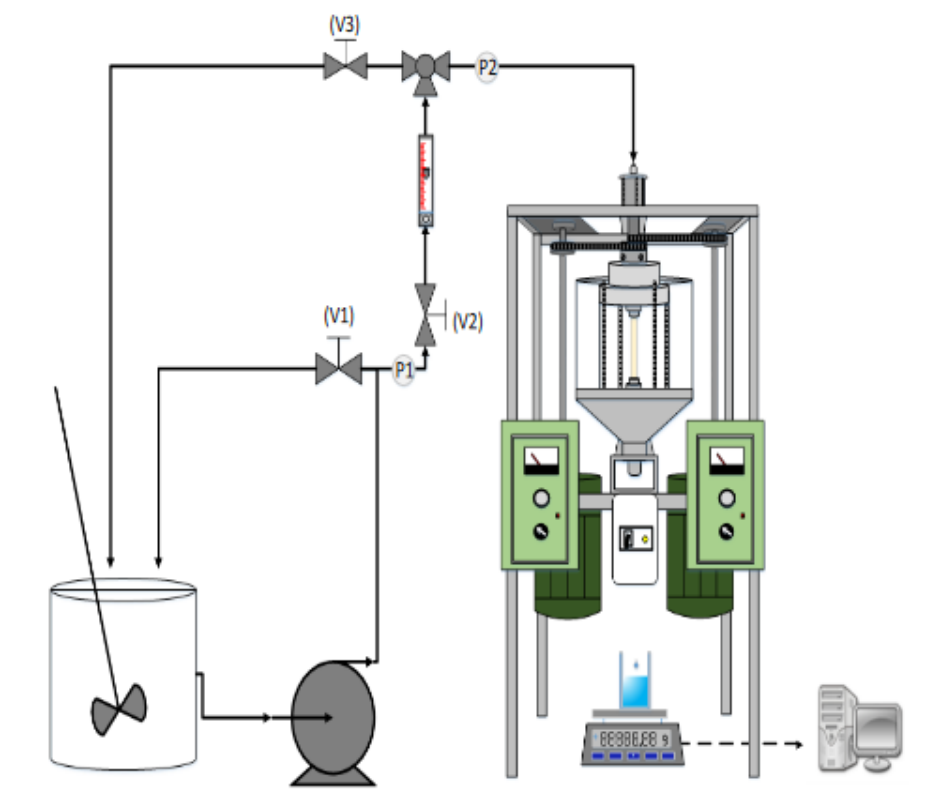
Figure 4. Overall assembly of the centrifugal filtration device.